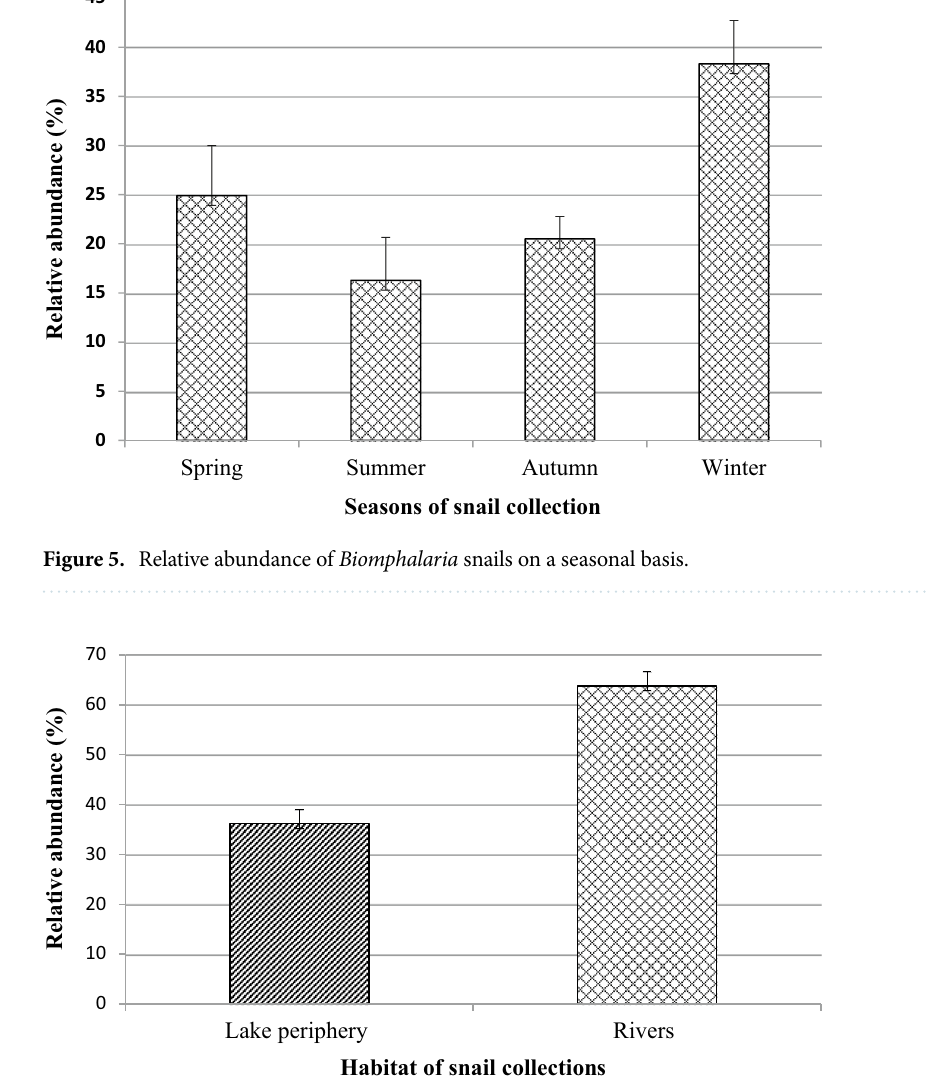
Snail examined for Snail count cercaria S. mansoni cercaria